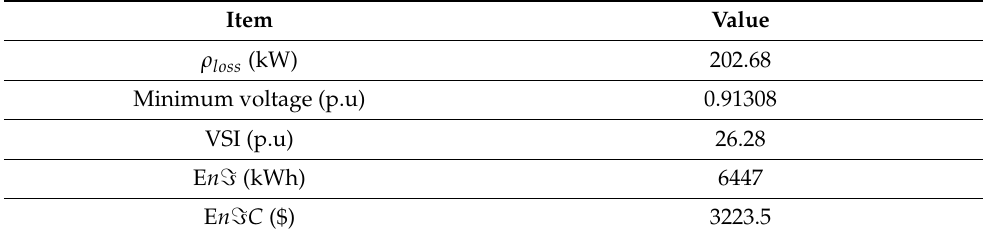
Table 2. Basic numerical results of 33-bus distribution network.